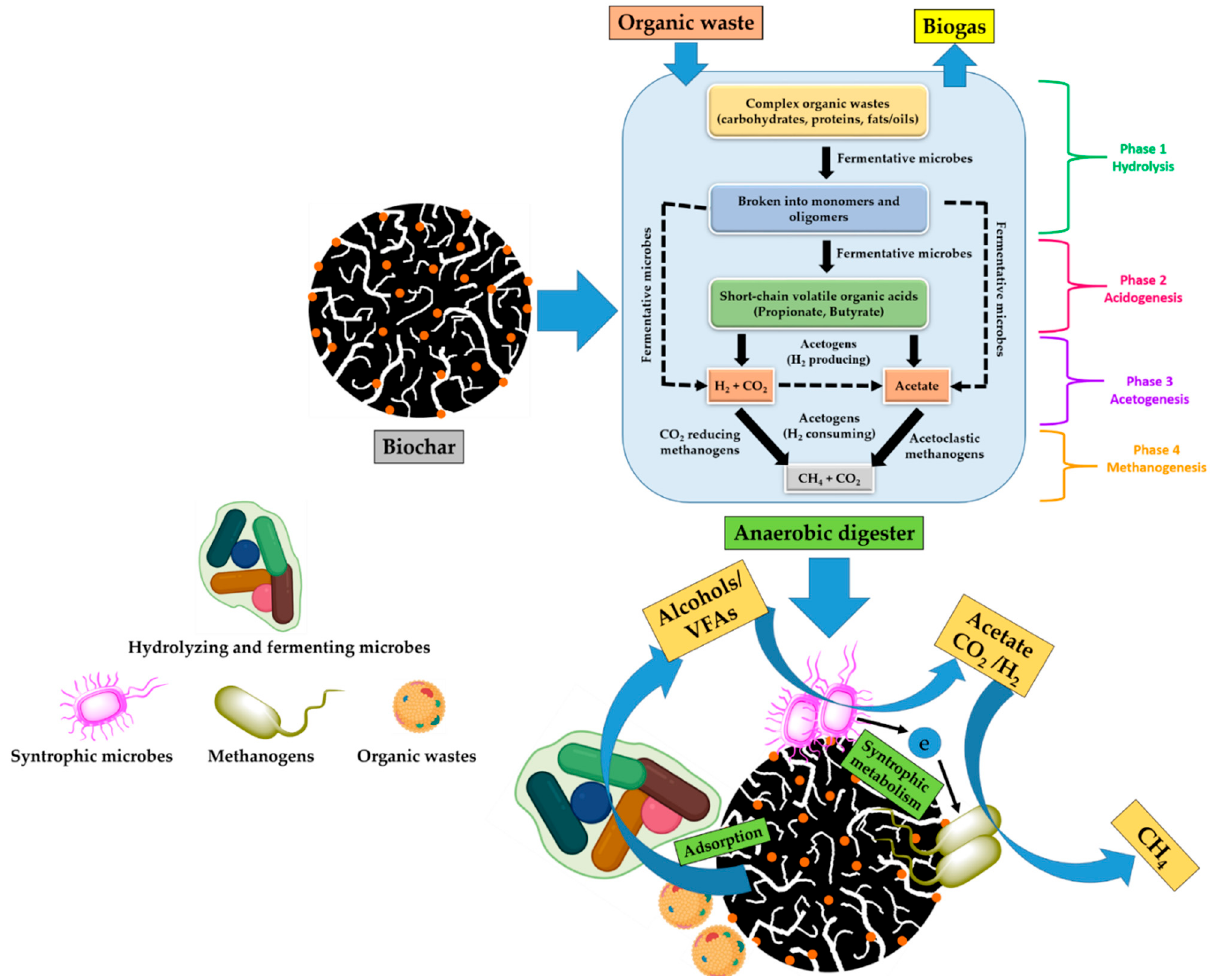
Figure 3. Anaerobic digestion system aided with the nano ‐ biochar for enhanced biogas produc ‐ tion.